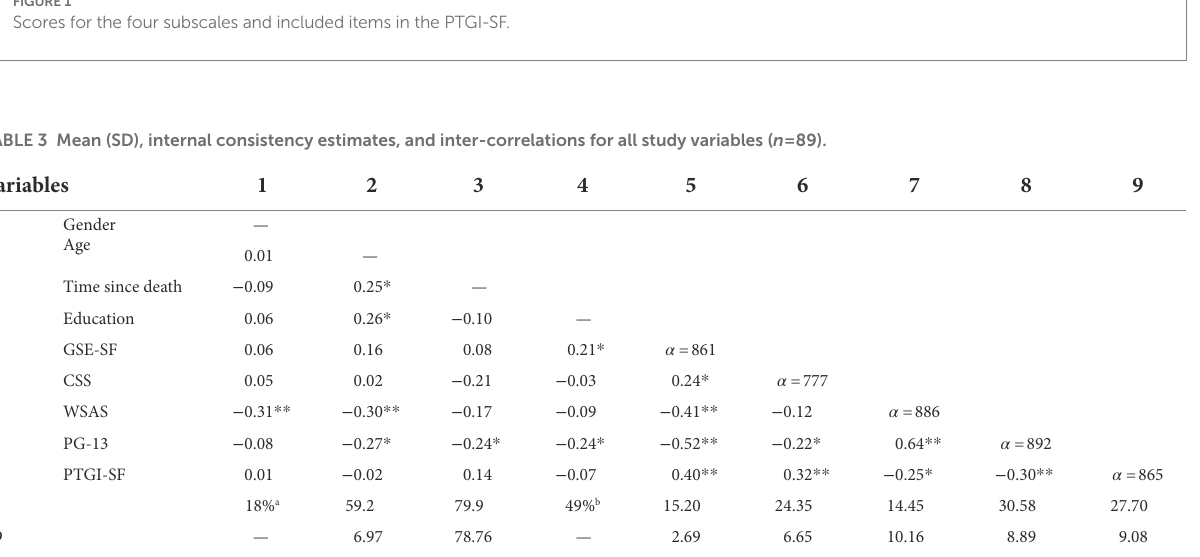
FIGURE 1 Scores for the four subscales and included items in the